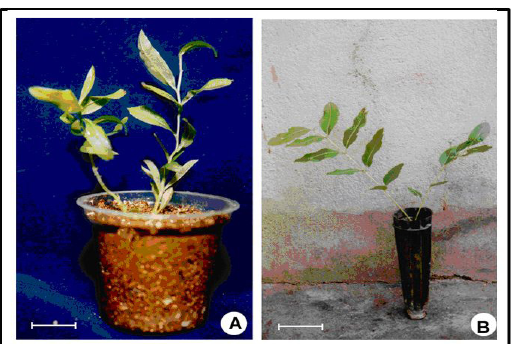
Fig. 3. Hardening of Soymida febrifuga ; (A) Micropropagated plantlet growing in a plastic cup after 2 weeks; (B) Transplanted tissue cultured plant grown in a pot after 6 weeks Tab. 3. In vitro rooting of Soymida febrifuga (after 5 weeks)